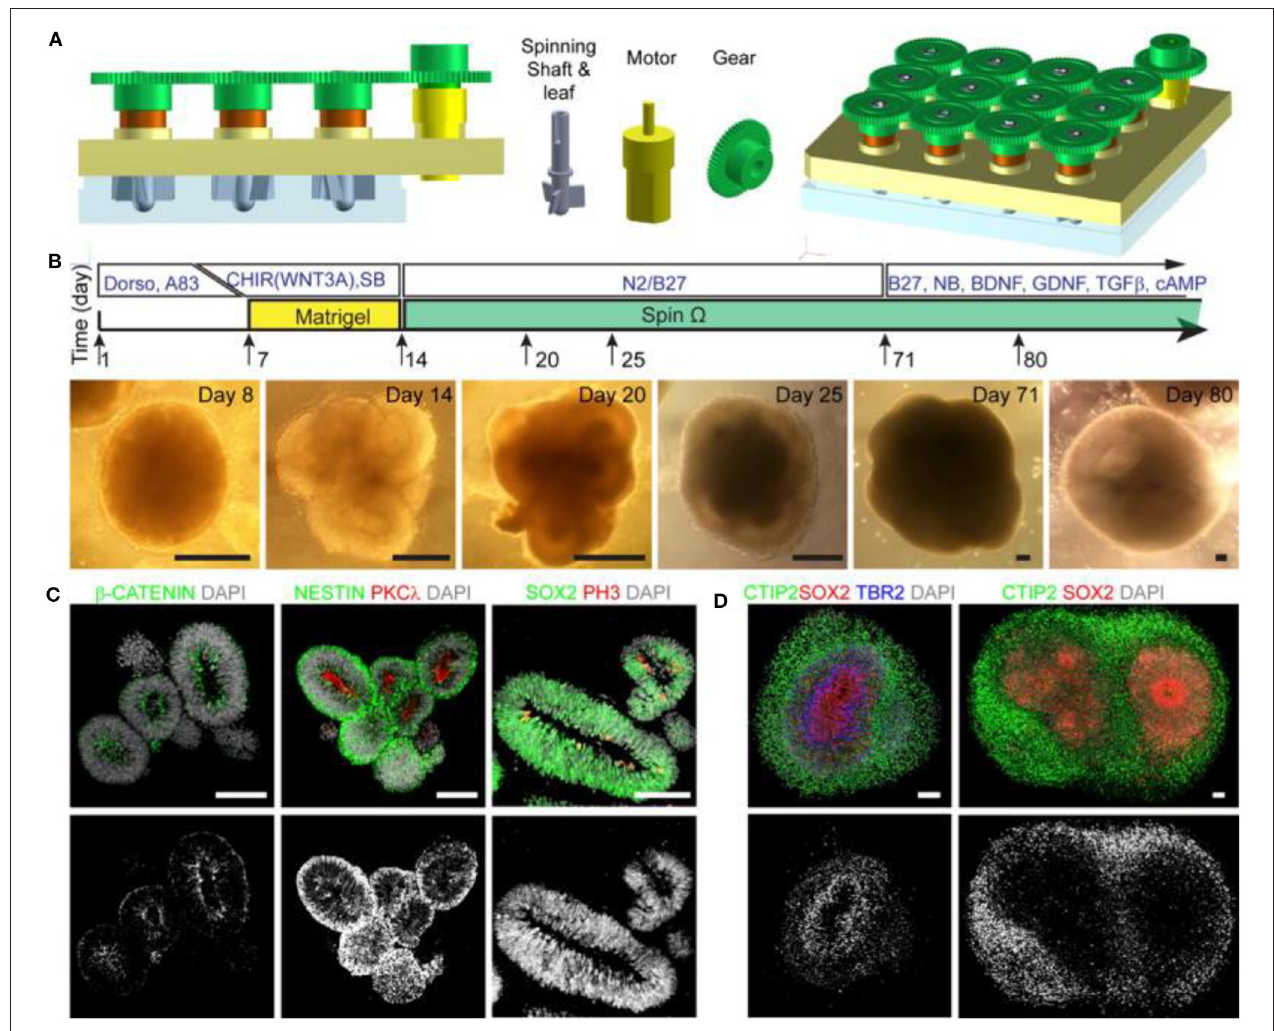
FIGURE 7 | (A) Design of spinning bioreactor used to produce brain organoids. (B) diagram of the organoid protocol and images at the different stages of development (scale bars are 200mm). (C,D) Organoids after immunostaining (scale bars are 100mm). This figure is reprinted under the terms of the Creative Commons Attribution License from Qian et al.